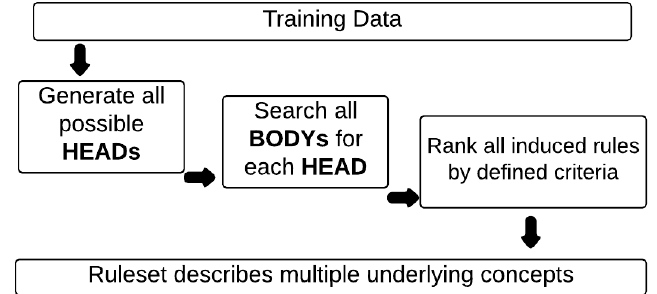
Figure 2. Main processes of generalised rule